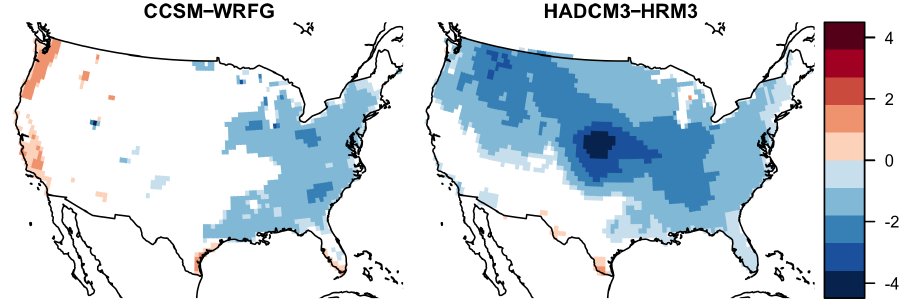
Figure 10. A heat map of the estimated average interaction effect for the IPL model. Only significant locations at the 0.10 level using pointwise inference are